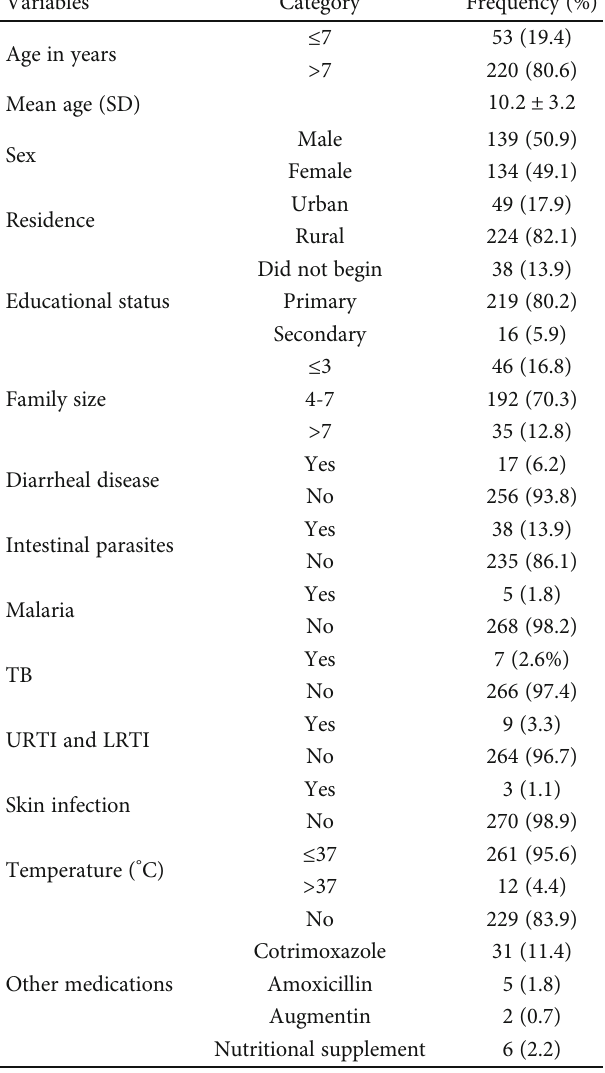
Table 1: Sociodemographic and clinical characteristics of HIV- infected children at Hawassa University Hospital ( N = 273